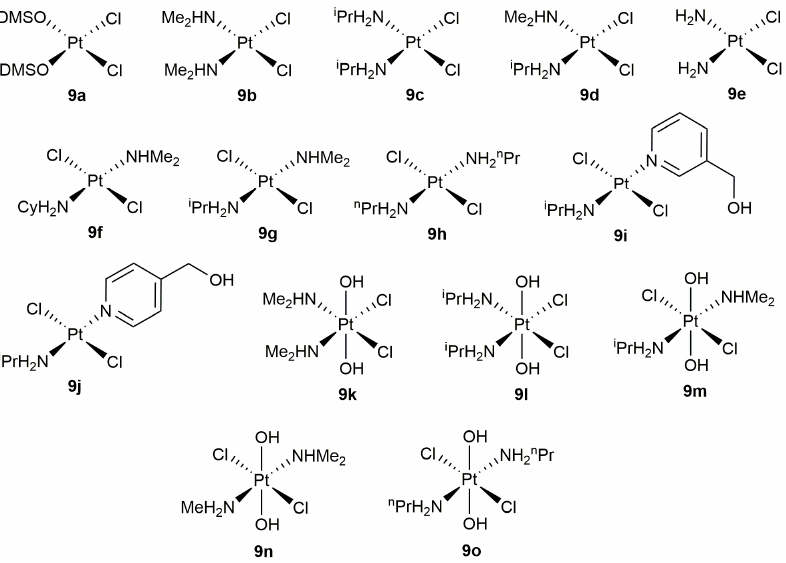
Figure 2. Structure of the platinum complexes 9a – o .